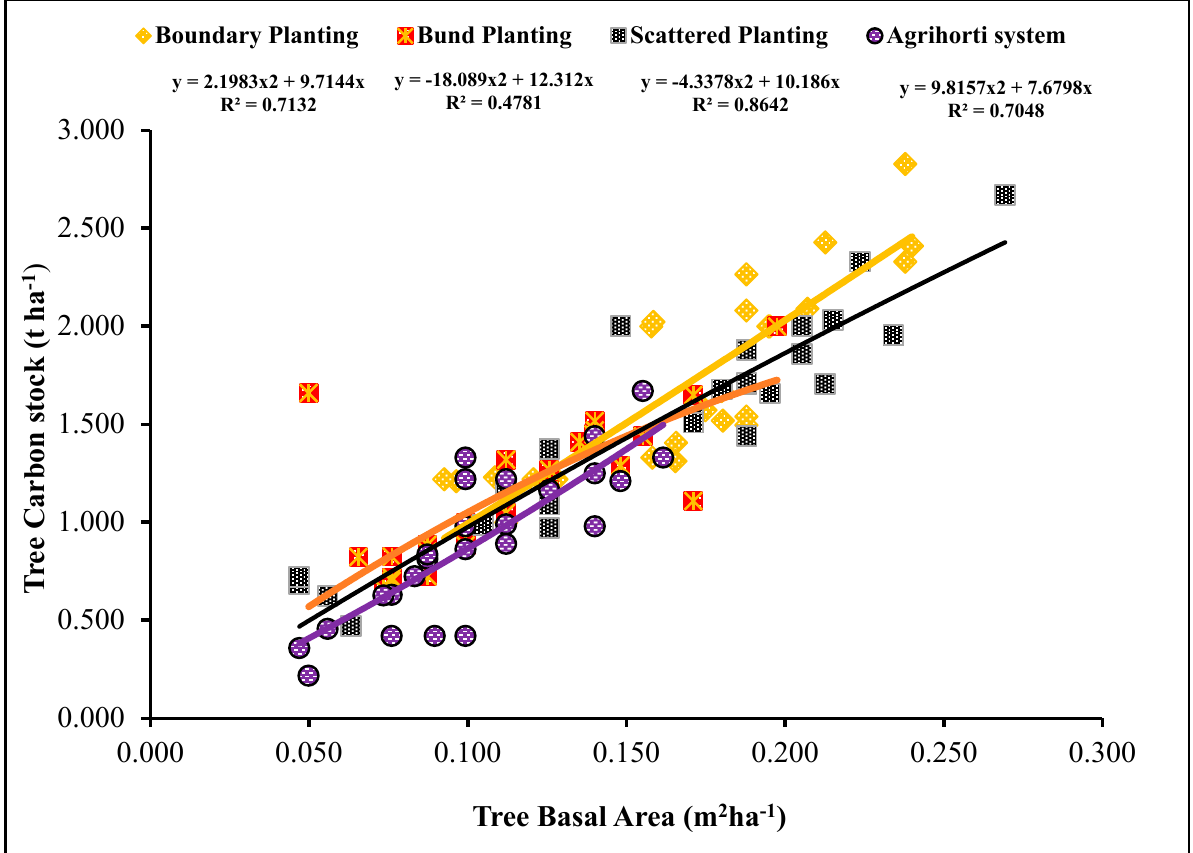
Figure 2. Distribution of biomass carbon stocks among different agroforestry systems in the semi- arid region.